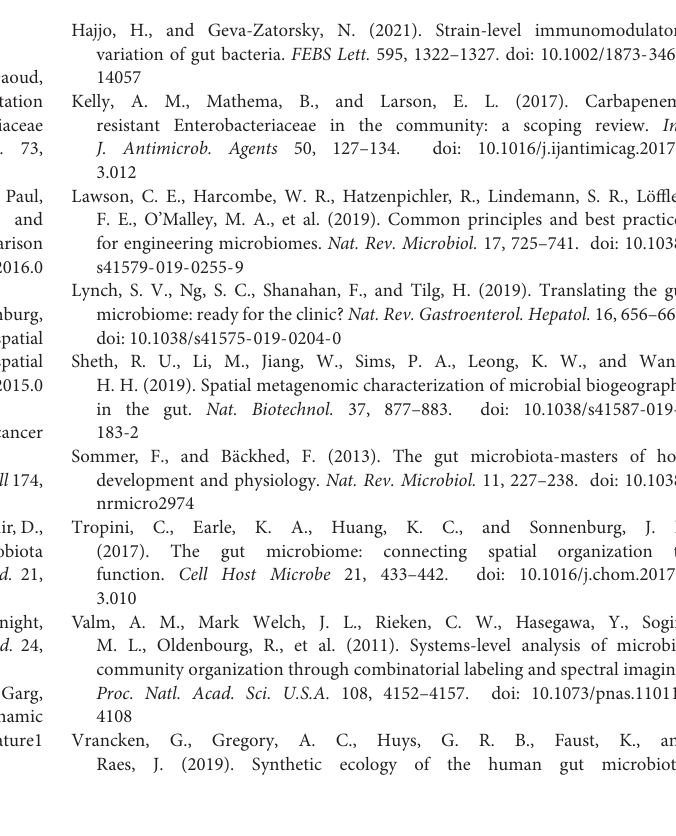
Supplementary Figure 1 | Classical analysis of a mixture of B. longum labeled bacteria with 10 different dual combinations. Flow cytometry dot plots representing B. longum dual-labeled with 10 different combinations of fluorophores. Differentiation of a mixture 10 different dual-labeled B. longum using classical analysis.